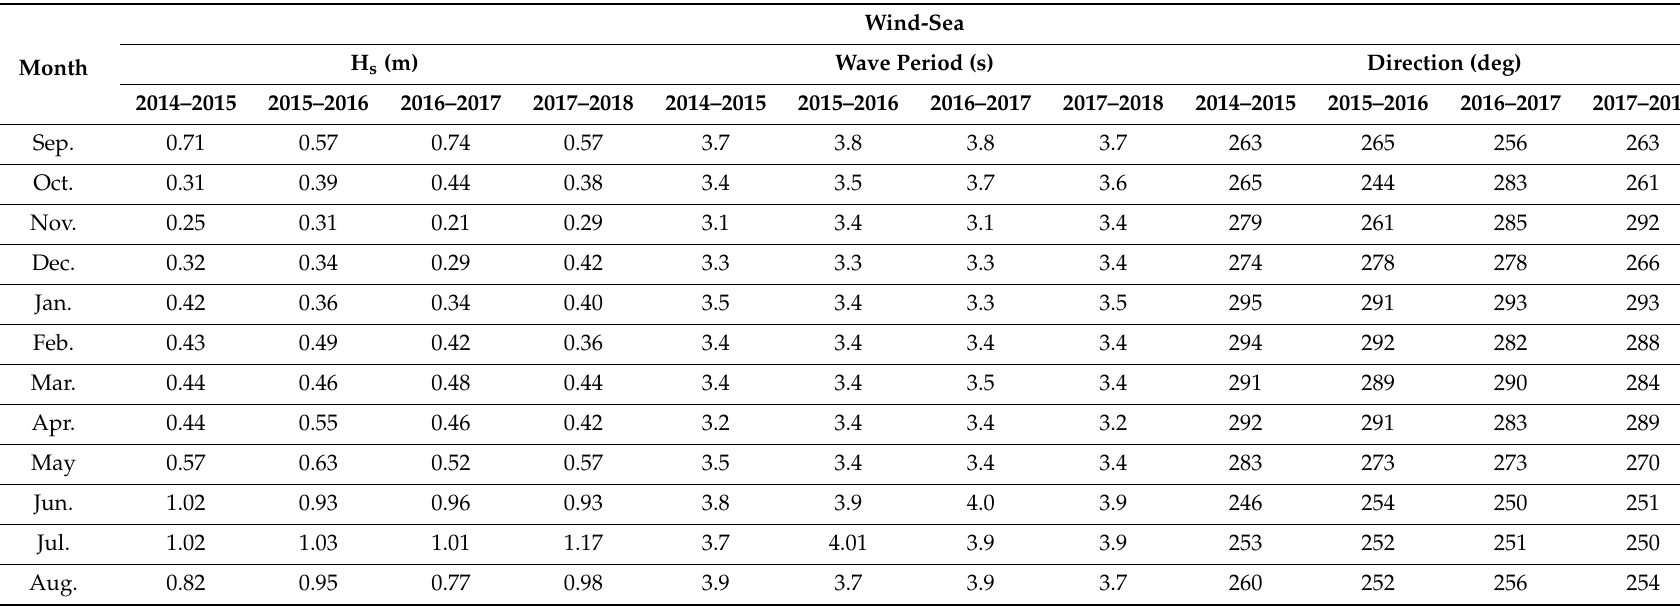
Table 3. Monthly average of significant wave height, mean wave period and mean wave direction of wind-sea measured at 15 m water depth for four